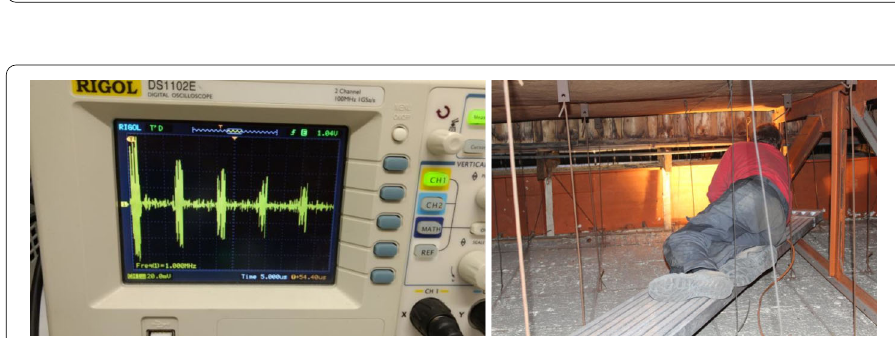
Figure 4 Left: An AScan which gives, via peak-to-peak-analysis, the time-of-flight of the ultrasonic waves to estimate the stress. Right: Recording data in the market hall